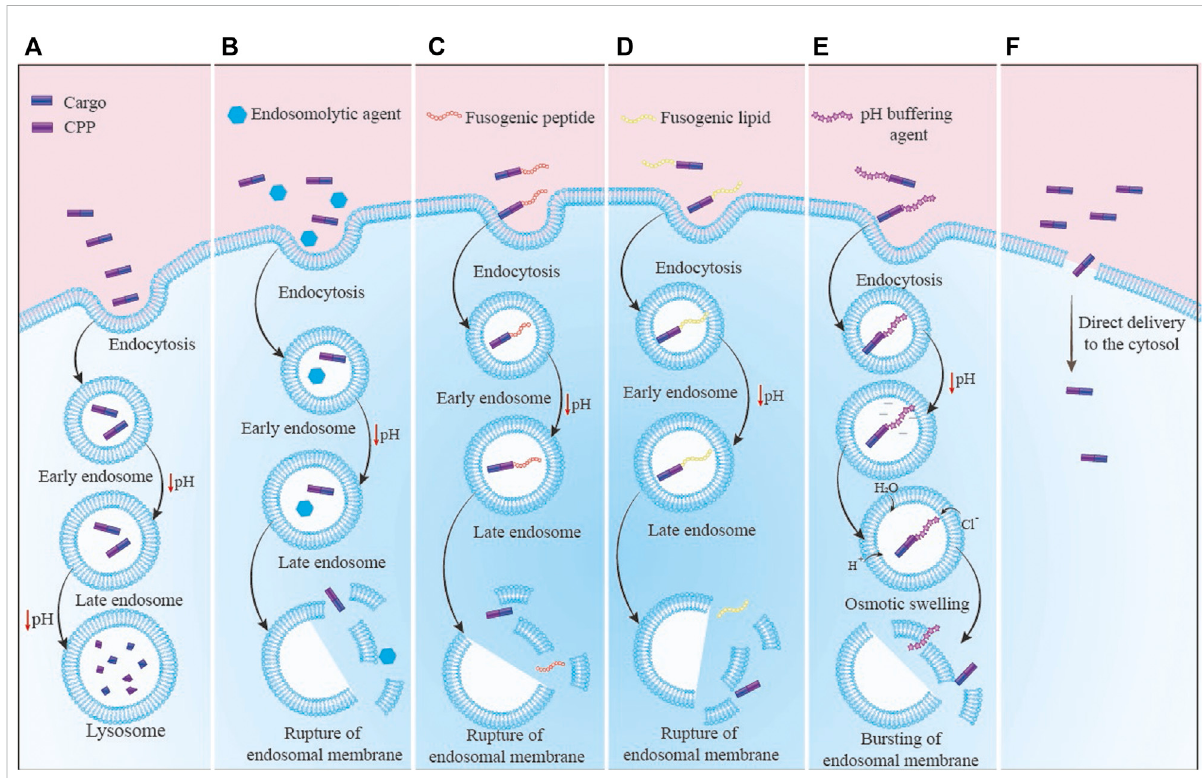
FIGURE 2 The CPP-cargo complex enters the cytosol through different routes: (A) Normal mode: the primary endosome has turned into a secondary endosomeand fi nally into an endolysosome, whichhas led to thedestruction ofthe complex; (B) Endosomolytic agents: There is an endosomolytic agent along with CPP that destructs the endosome membrane and results in the release of complex into cytosol space; (C) Fusogenic peptide: the fusogenic peptide is conjugated to CPP, which causes the degradation of the endosome membrane and the complex is released into the cytosol space; (D) Fusogenic lipids: Fusogenic lipid interacts with the inner surface of the endosome membrane and causes destruction of the membrane. Then, the complex is rescued into the cytosol space; (E) Proton sponge: In this mechanism, buffering agents linked to CPP-cargo complex or the residues available in CPP sequence like histidine enter water inside the endosomes. After endosome swelling and its destruction, the CPP-cargo complex is released into cytosol space; (F) Direct transfer of CPP: CPPs with a speci fi c sequence lead to enter the CPP-cargo complex into the cytosol directly without the need for the endosome escape